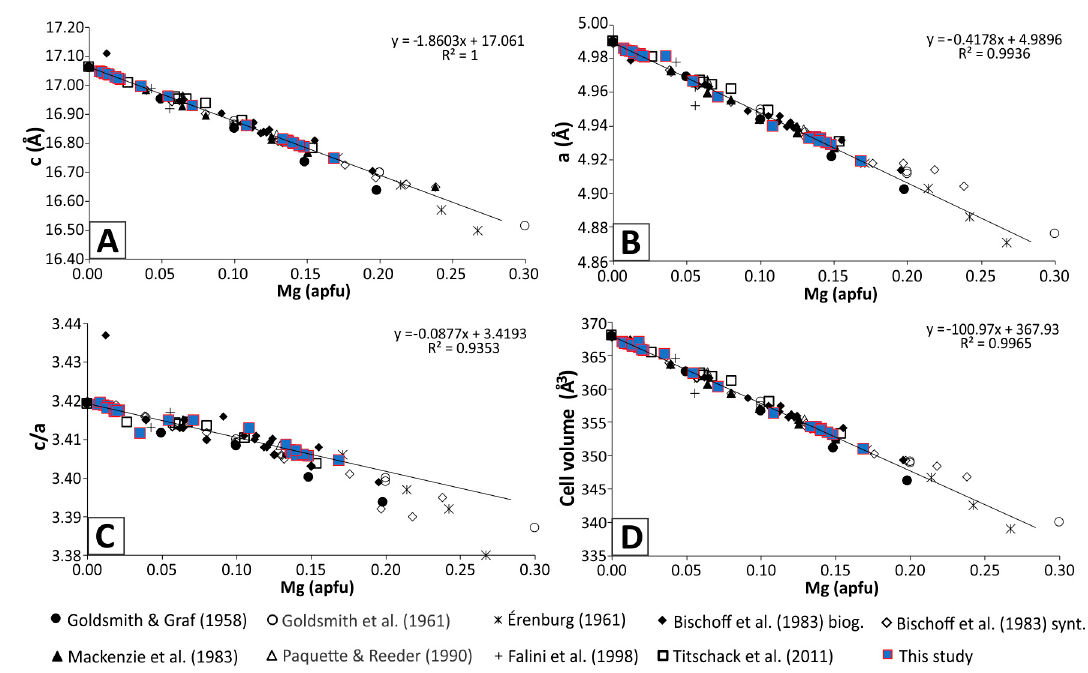
Figure 10. Plot of Mg content in magnesian calcite against lattice parameters from published data. Data of our study are represented as blue squares with red border. The equation of the line and correlation coefficient R 2 refers to the data of our study. ( A ) Correlation of the length of crystallographic axis c and molar fraction of MgCO 3 ; ( B ) Correlation of the length of crystallographic axis a and molar fraction of MgCO 3 ; ( C ) Correlation of ratio c / a of the crystallographic axes and molar fraction of MgCO 3 ; and, ( D ) Correlation of cell volume and molar fraction of MgCO 3 .